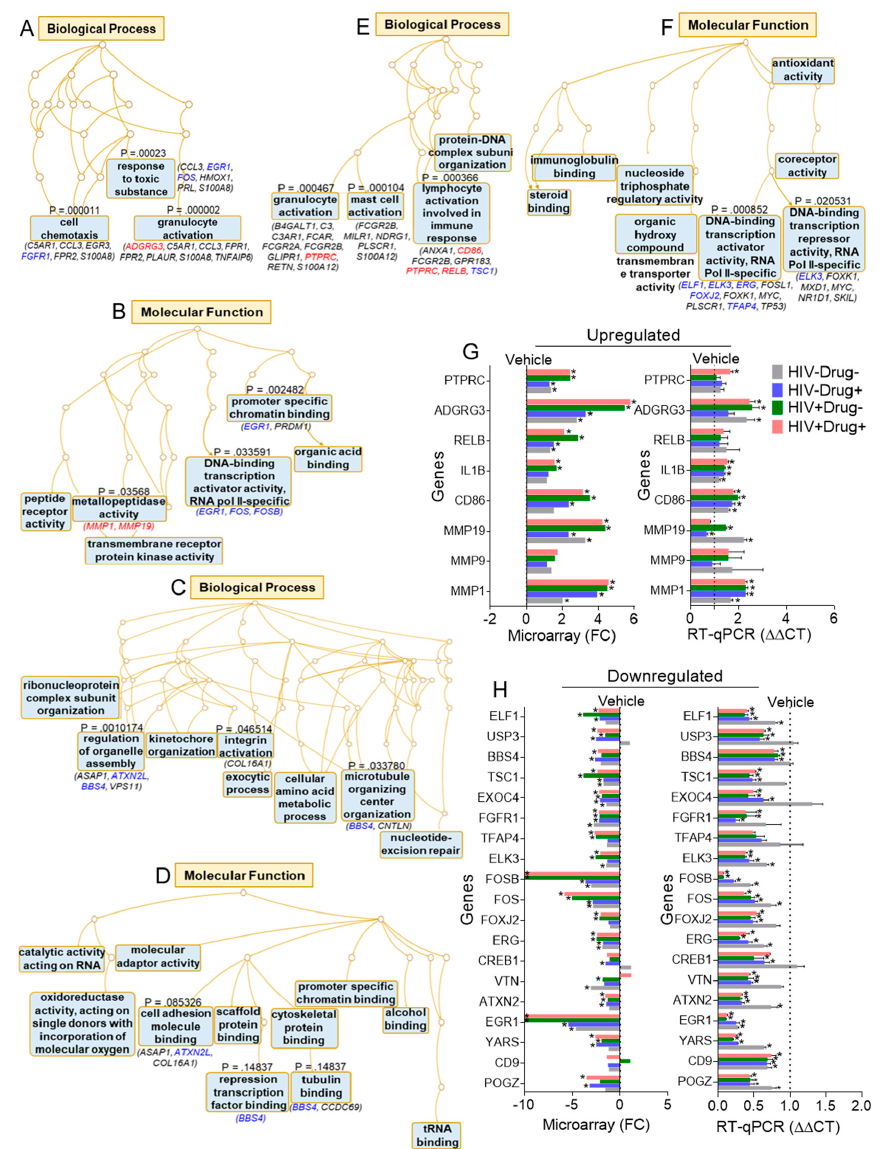
Figure 4. Gene Ontology (GO) terms and PCR validation of selected DEGs: Biological processes and molecular functions of selected DEGs as determined by the overrepresentation analysis method from the web-based GEne SeT AnaLysis Toolkit. ( A , B ) SE, ( C , D ) SE-Drug, and ( E , F ) SE-HIV. Colored fonts are validated genes with blue as downregulated and red as upregulated genes. ( G , H ) RT-qPCR validation of selected DEGs in Figure 4A–F (blue and red fonts). Ordinary one-way ANOVA test (Dunnett’s correction) was used to determine the differences between the SE groups as compared to HIV − Drug − . Error bars indicate standard deviation of three technical replicates. * p < 0.05, and nonsignificant labels were not shown for clarity.